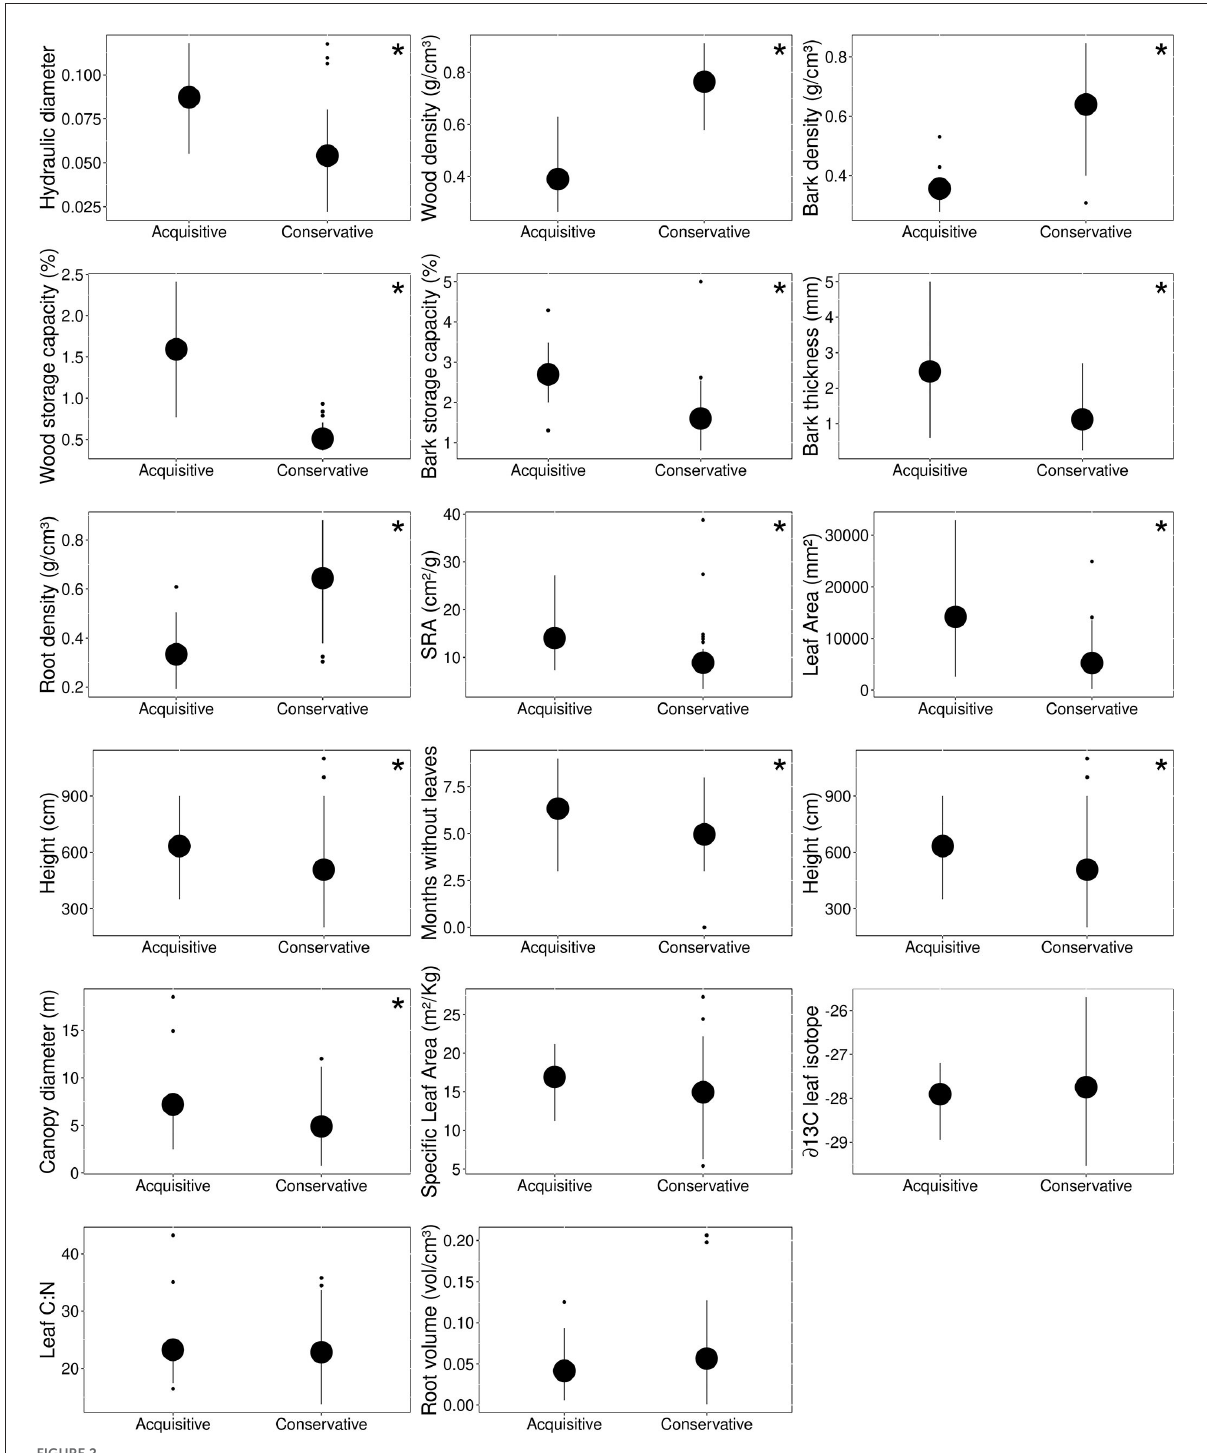
FIGURE2 Functional group trait values. The mean and standard deviation of the functional attributes of conservative and acquisitive groups were found based on Calinski’s criteria. Traits that differ between groups by GLM models are represented by *, see all analysis values in Supplementary Table